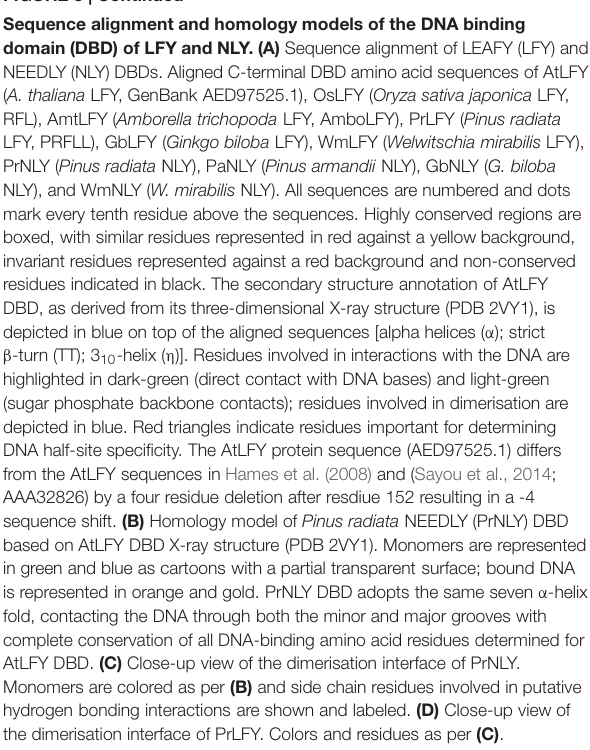
Frontiers in Plant Science |